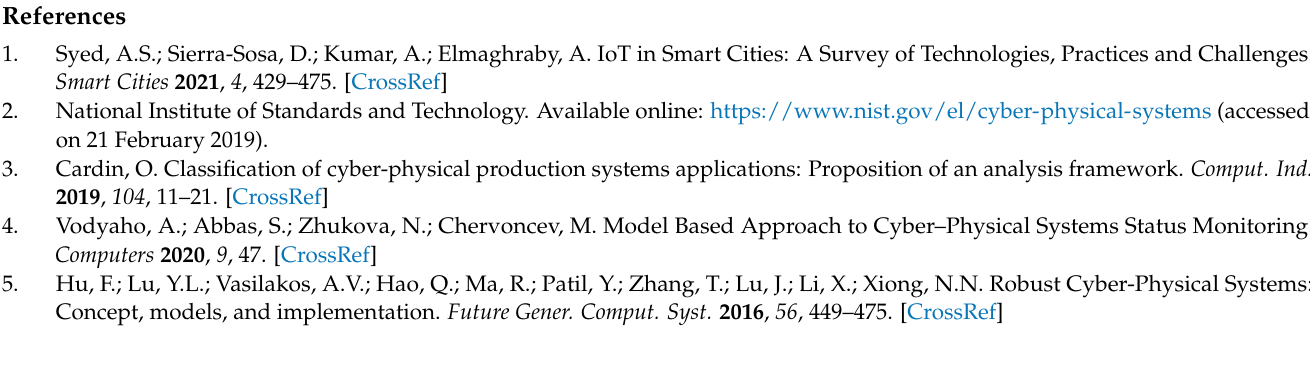
Figure A3. ( a ) A solution represented in STN 1 ( V 1 , A 1 ) for the first type of tasks obtained after resource failure; ( b ) A solution represented in STN 2 ( V 2 , A 2 ) for the second type of tasks obtained after resource failure.